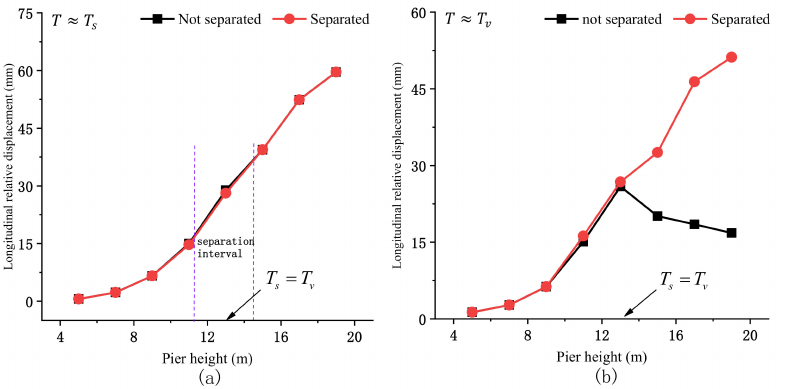
Figure 9. Longitudinal displacement at different pier heights: ( a ) maximum longitudinal relative displacement of girder and pier when T ≈ T s ; ( b ) maximum longitudinal relative displacement of girder and pier when T ≈ T v